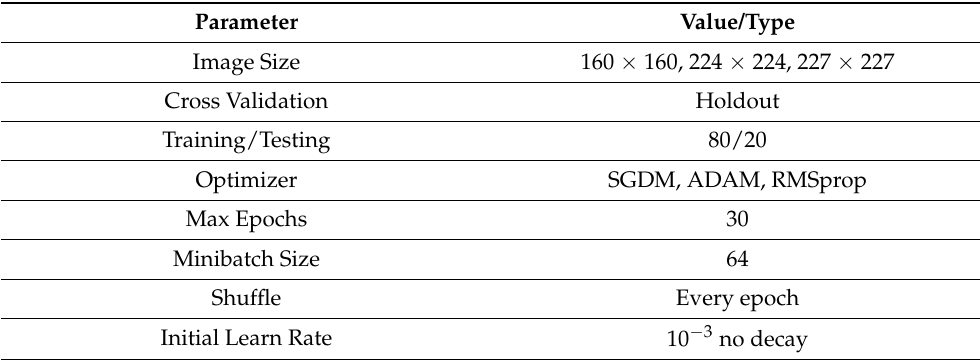
Table 3. HyperParameters for All CNN